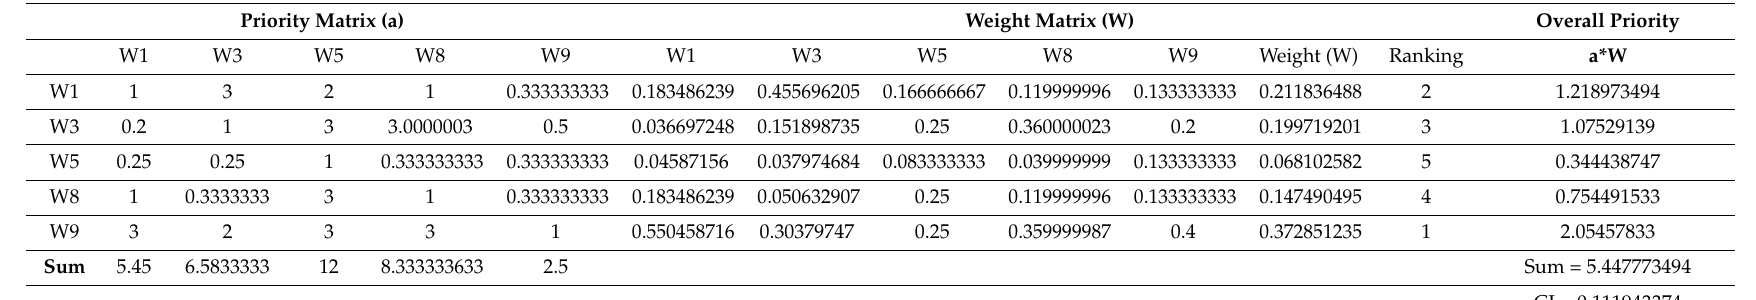
Table 4. Priority calculations for weakness